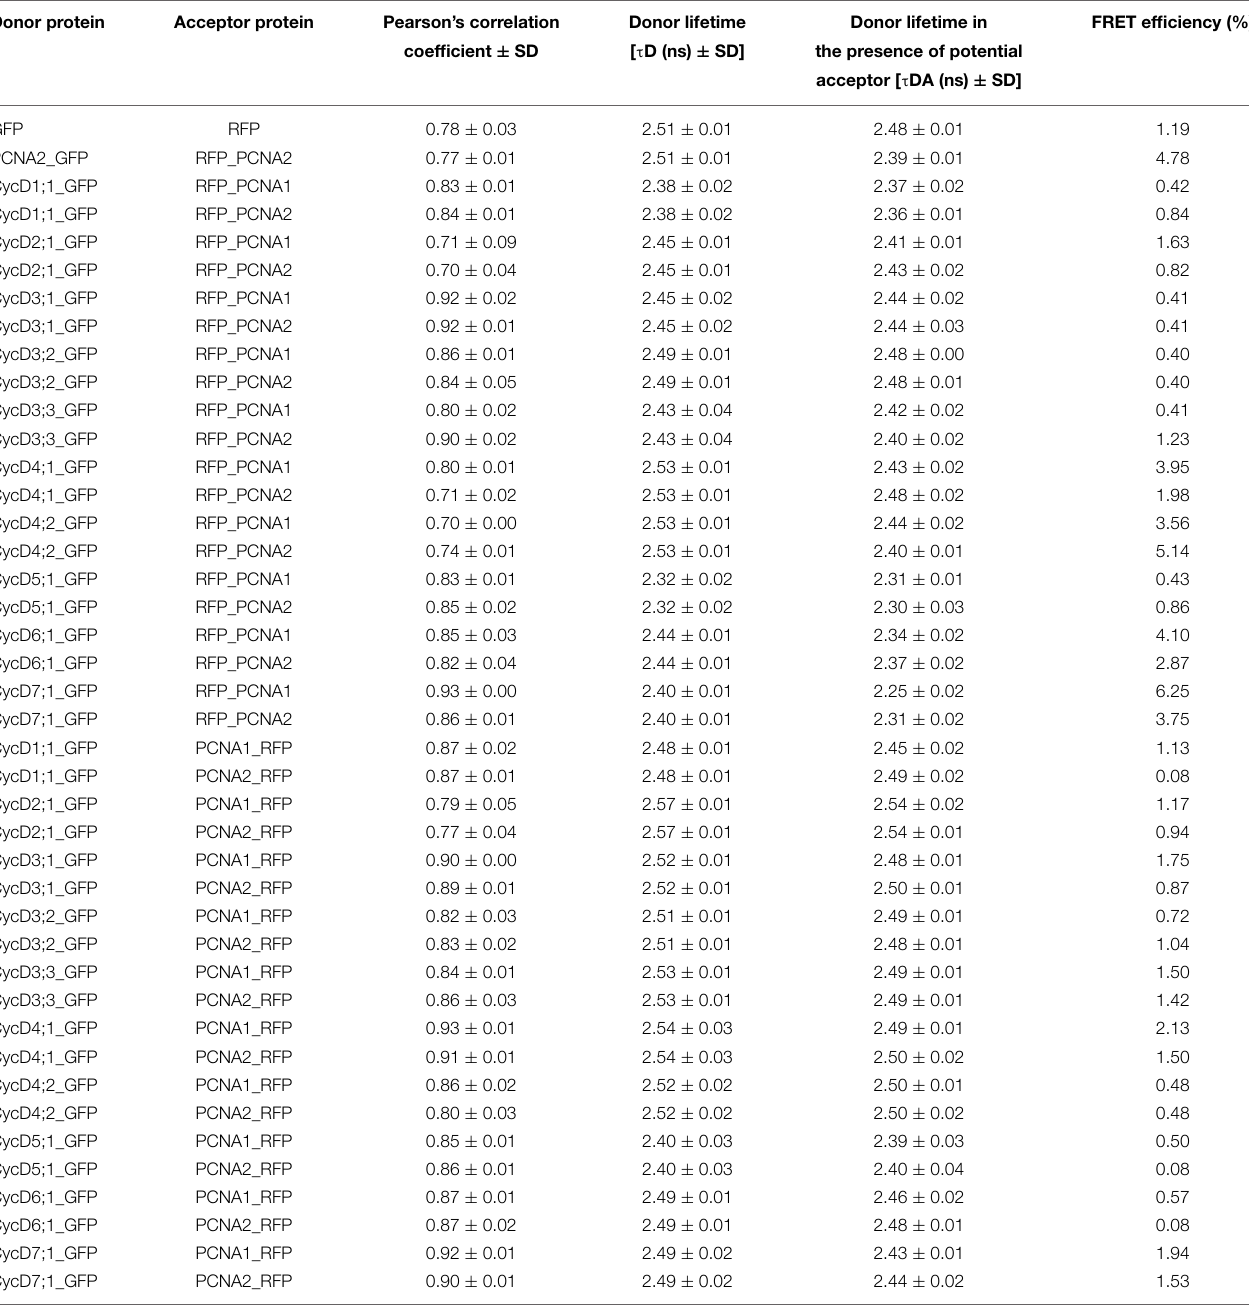
TABLE 1 | Results of FLIM-FRET analysis and co-localization measurement (Pearson’s correlation coefficient). Donor